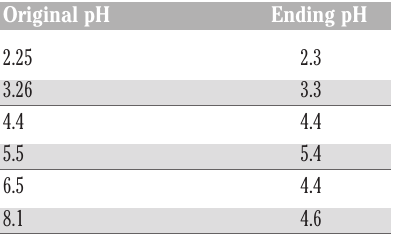
Table 1. The pH of the water used to treat S. aureus cuttings. The original pH is the pH of the water added to the plant vessel, the ending pH is the pH of the water in which the plant grew.